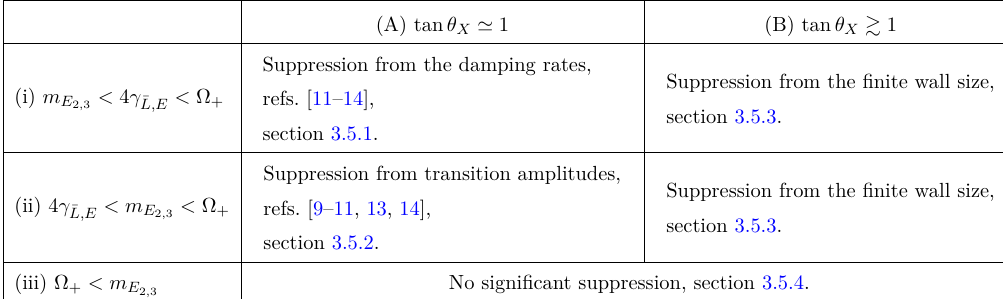
Table 1 . A dominant factor of suppression on ∆ E ( ω ) in each parameter regime discussed